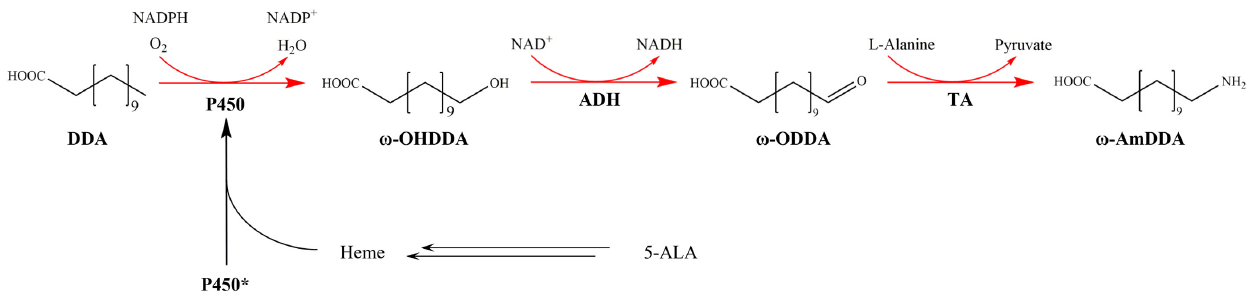
Figure 1. Biosynthetic pathway of ω -AmDDA. The double arrows indicate a multistep reaction. P450*, P450 without hydroxylation activity; DDA, dodecanoic acid; ω -OHDDA, 12-hydroxydodecanoic acid; ω -ODDA, ω -oxododecanoic acid; ω -AmDDA, ω -aminododecanoic acid; 5-ALA, 5-aminolevulinic acid.